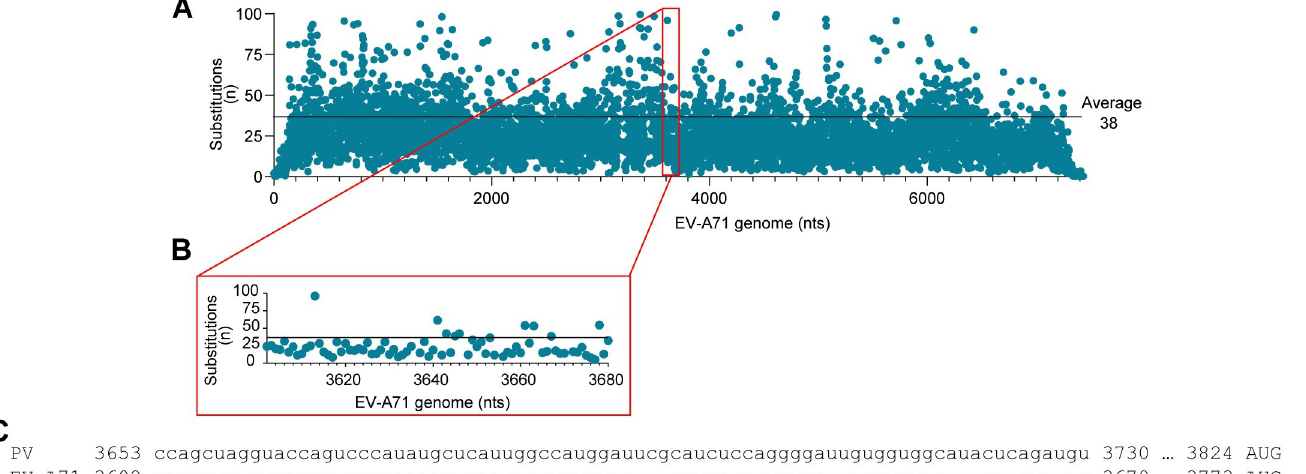
Fig 11. Identification of an RNA sequence upstream of the AUG codon required for eIF2A/2D-dependent translation. (A) Nucleotide substitutions at each position across the EV-A71 genome have been defined by deep RNA sequencing. The average substitution frequency is 38. Some regions exhibit a lower average; these regions of the genome may encode cis -acting RNA elements. Numerical data provided as Supporting information (S1 Data). The entire data set is available at the GEO repository under accession number GSE183959. (B) The region from 3,602–3,679 of the EV-A71 genome exhibits a below-average frequency of nucleotide substitutions. This region corresponds to a sequence 78-nt upstream of the AUG used for eIF2A/2D-dependent translation. Numerical data provided as Supporting information (S1 Data). (C) Alignment of the corresponding nucleotide sequence and amino acid sequence reveals moderate to high sequence identity among enterovirus (PV, EV-A71, CVB3, and EV-D68). Black asterisks indicate conservation across all enteroviruses; red asterisks indicate conservation in three of the four